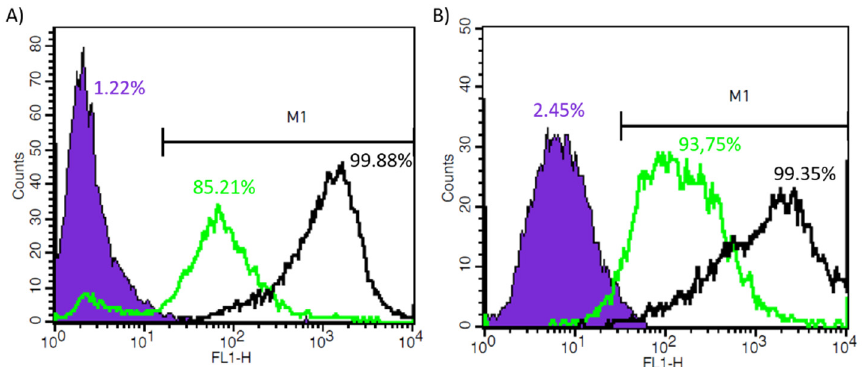
Figure 10. Detection and quantification by flow cytometry of HeLa ( A ) and MCF-7 ( B ) cellular uptake of FITC-labelled SFNs (green) and FITC-labelled RA-SFNs at an equivalent RA concentration of 0.226 mg/mL (black) after 24 h of cell exposure. In both cases, cells without any treatment were used as negative control (purple).